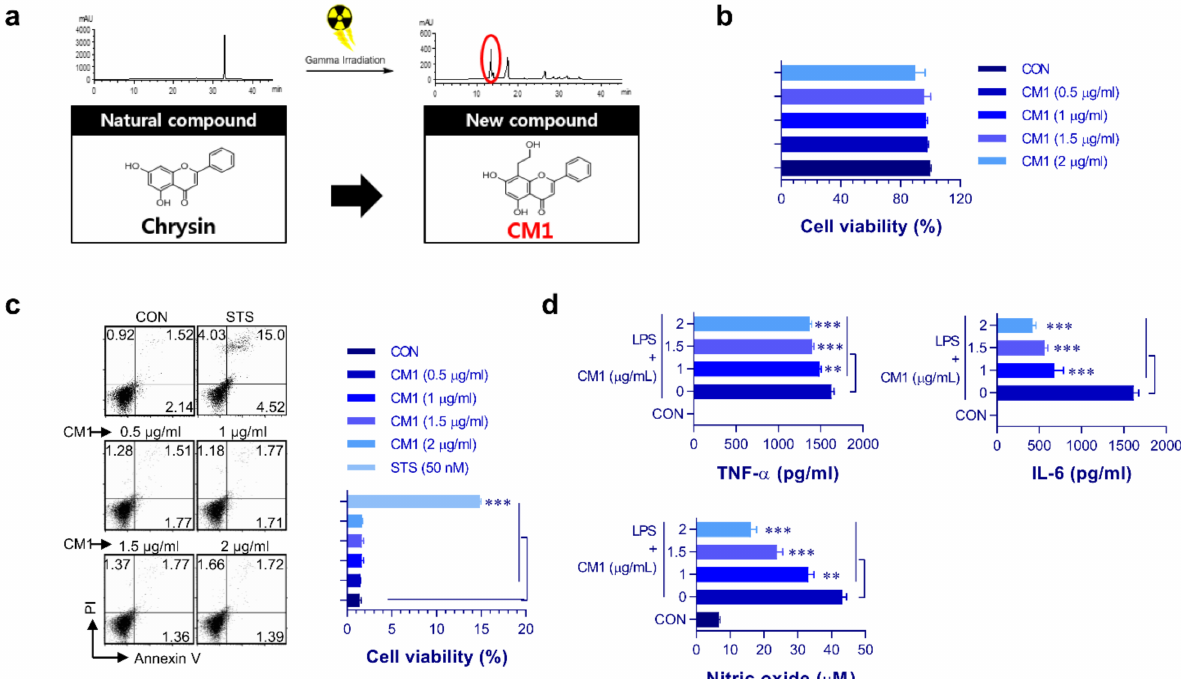
Figure 1. Cell viability and anti-inflammatory effect of CM1 on RAW264.7 cells. HPLC chromatogram and chemical structure of CM1 are shown ( a ). RAW264.7 cells were treated with CM1 (0.5, 1, 1.5, and 2 µ g/mL) for 24 h. Cell viability was assessed using the MTT assay ( b ). RAW264.7 cells were treated with CM1 (0.5, 1, 1.5, and 2 µ g/mL) and 50 nM staurosporine for 24 h, and cytotoxicity was assessed by annexin V/PI staining and flow cytometry ( c ). Staurosporine was used as a positive control for measuring cell death. RAW264.7 cells were treated with LPS (200 ng/mL) or LPS and CM1 (1, 1.5, and 2 µ g/mL) for 24 h, and TNF- α , IL-6, and NO levels in the culture medium were analyzed by ELISA and Griess assay ( d ). All bar graphs show the mean ± SD of three samples from one representative plot among three independent experiments. Statistical analysis was performed by one-way ANOVA in conjunction with Tukey’s multiple test; ** p < 0.01 and *** p < 0.001. CON: untreated RAW264.7. Abbreviations: MTT, 3-(4,5-dimethylthiazol-2-yl)-2,5-diphenyl-2 H -tetrazolium bromide; PI, propidium iodide; LPS, lipopolysaccharide; TNF, tumor necrosis factor; IL, interleukin; NO, nitric